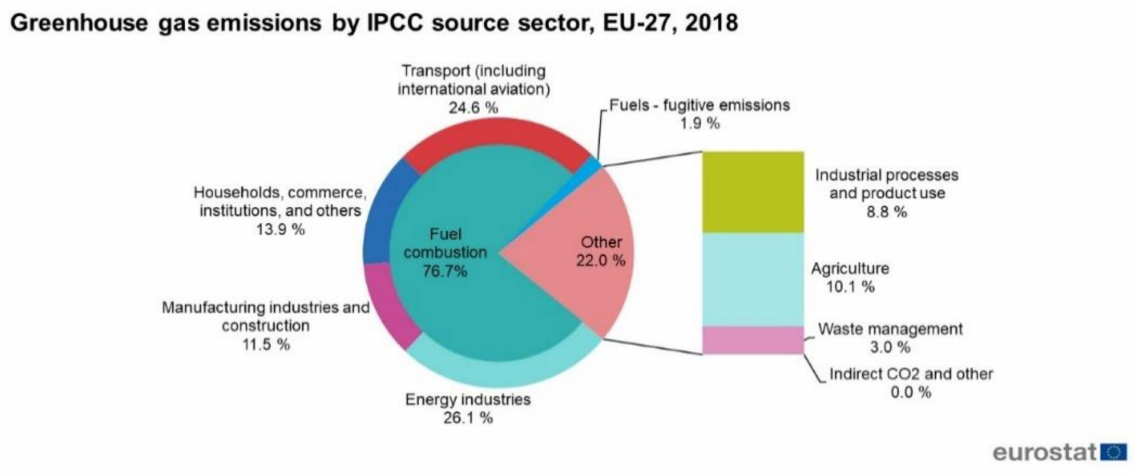
Figure 1. Greenhouse gas emissions by IPCC source sector, EU-27, 2018